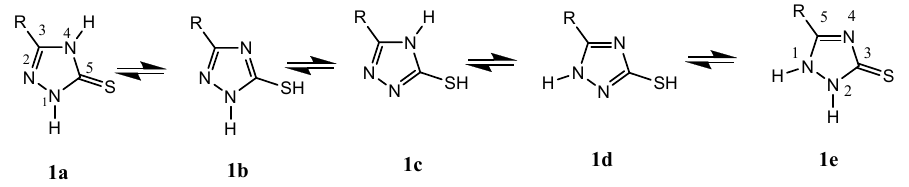
Figure 1. Tautomerism of 1,2,4-triazole thione.